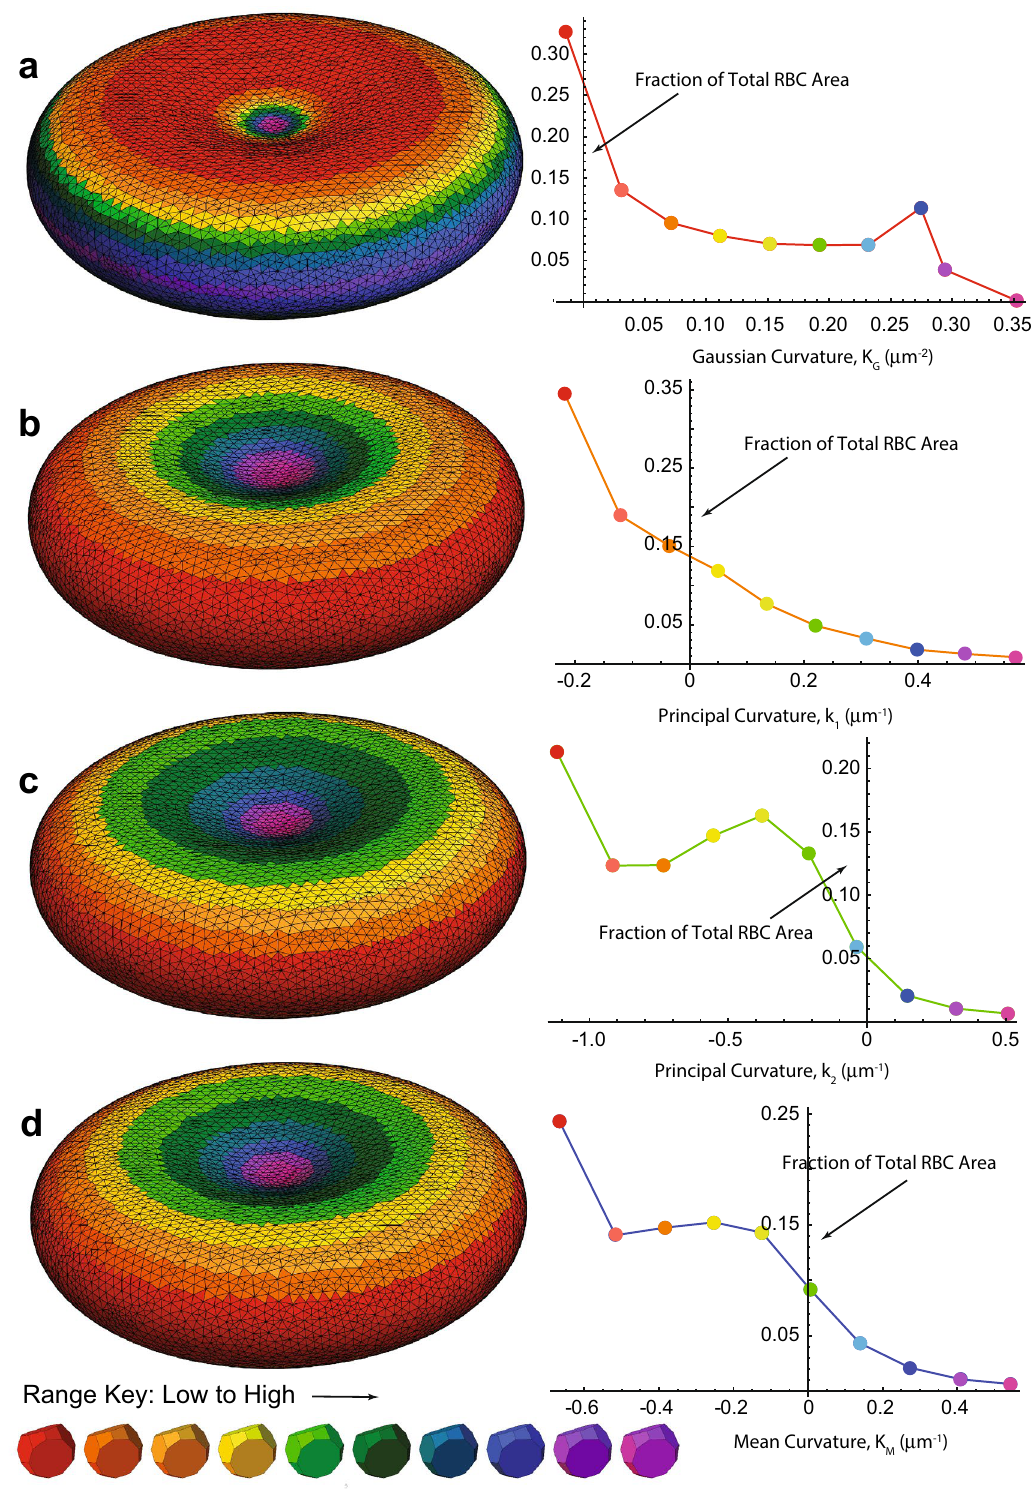
Figure 3. Positional dependence of the four types of curvature on the surface of the model RBC. ( a ) Gaussian Curvature, K G ; ( b ) Principal Curvature (maximum), k 1 ; ( c ) Principal Curvature (minimum), k 2 ; and ( d ) Mean Curvature, K M . On the right of each cell is the graph of mean value (of the respective curvature) versus the fraction of the RBC area that has the curvature in a specified sub-domain of values. Specifically, the minimum and maximum values of each curvature were idenified, then the whole domain of values was divided linearly into 10 sub-domains (bins) with each assigned a colour-code, as shown in the given Range Key. The area of each triangle was computed (“Theory of Methods”; and Notebook 2), so the total area occupied by triangles in a given bin could be expressed as a fraction of the total RBC area, 128 μm 2 . For speed of computation the triangularization was made with fewer mesh points than for Fig. 1, specifically 13,640 triangles and 6822 mesh